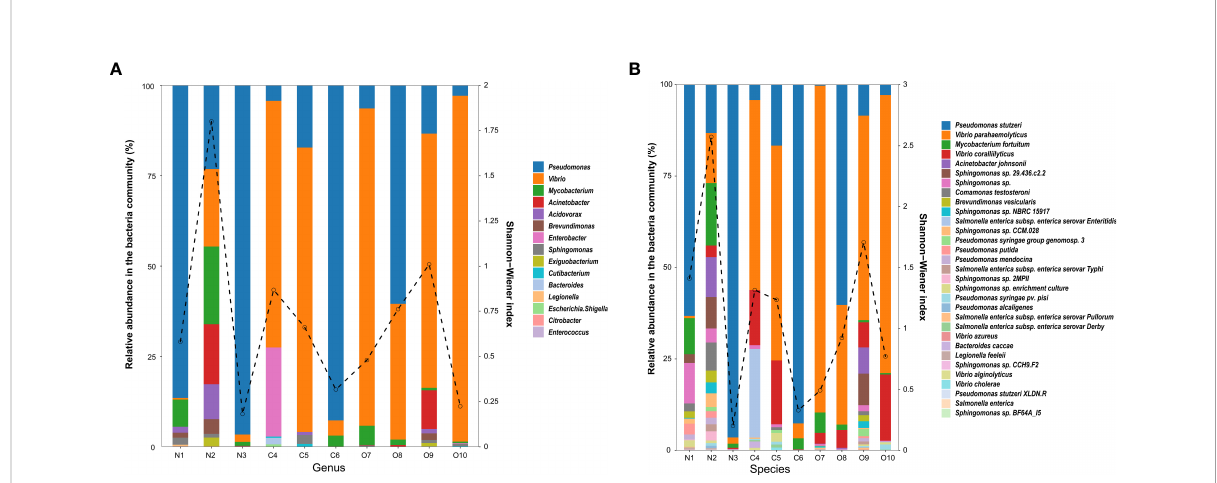
FIGURE 2 Relative abundance of the potentially pathogenic bacterial genus (A) and species (B) in the estuary. The dashed line indicates the Shannon- Wiener